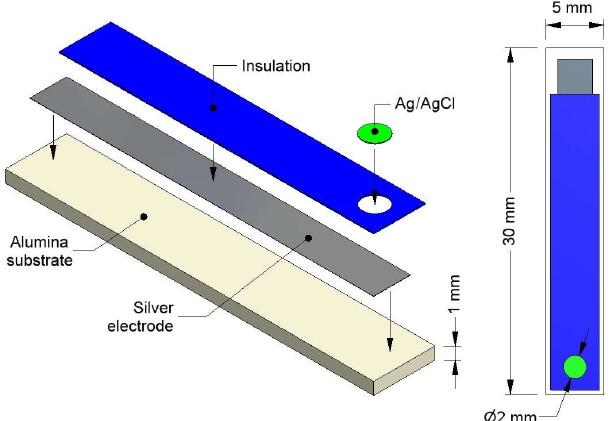
Figure 2. Schematic illustration of the potentiometric sensor construction.